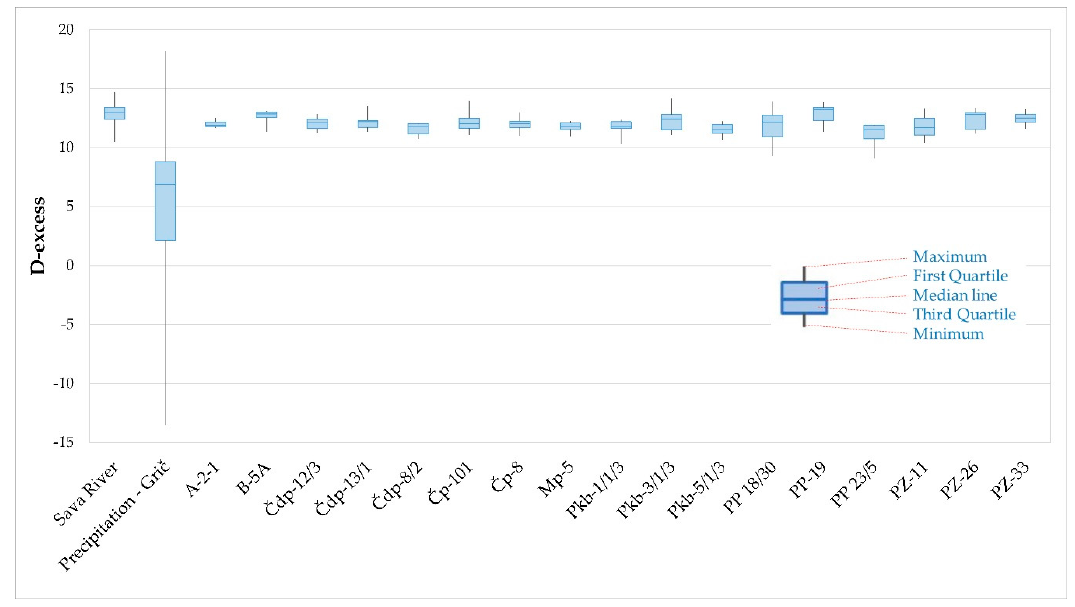
Figure 5. Average deuterium excess (d-excess) values in samples of the Sava River, precipitation, and groundwater.